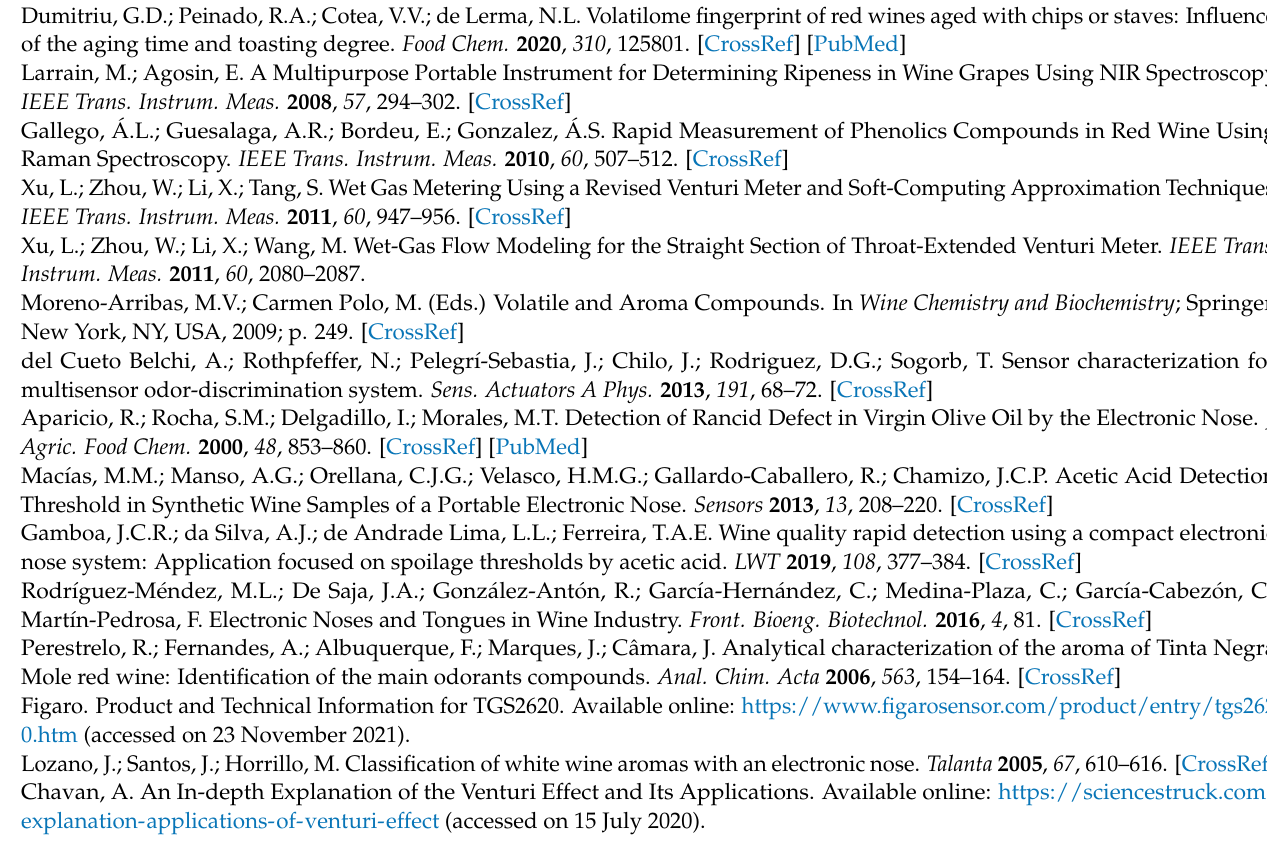
Figaro. Product and Technical Information for TGS2620. Available online: https://www.figarosensor.com/product/entry/tgs262 0.htm (accessed on 23 November